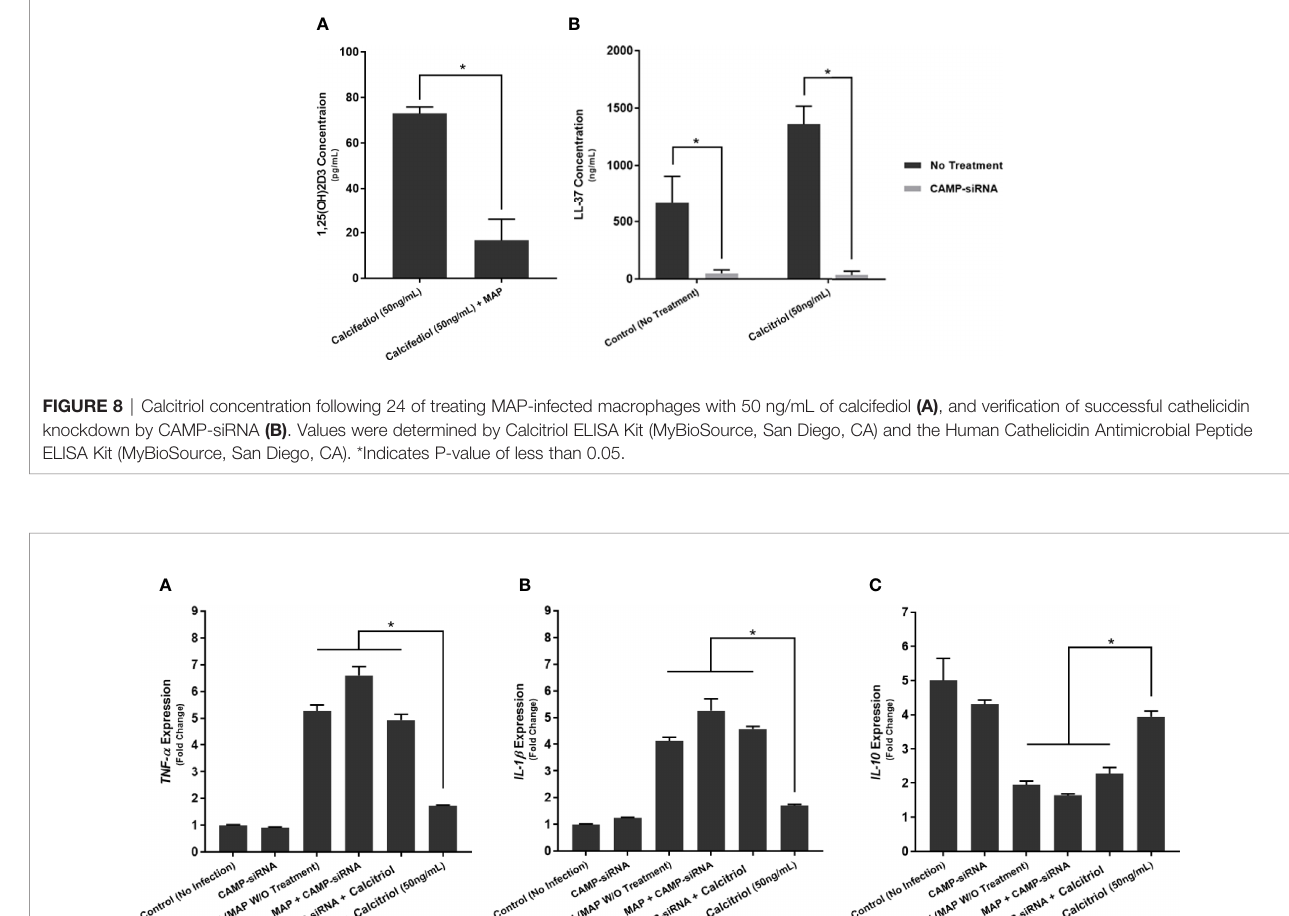
FIGURE 9 | Effects of CAMP-siRNA transfection on the expression of TNF- a (A) , IL-1 b (B) , and IL-10 (C) in MAP-infected macrophages. *Indicates P-value of less than 0.05.